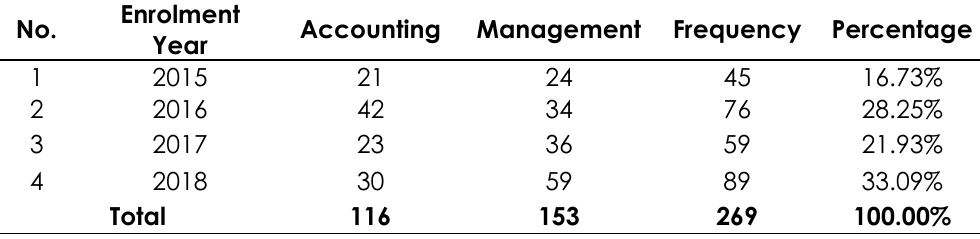
Respondents’ Data Based on Enrolment